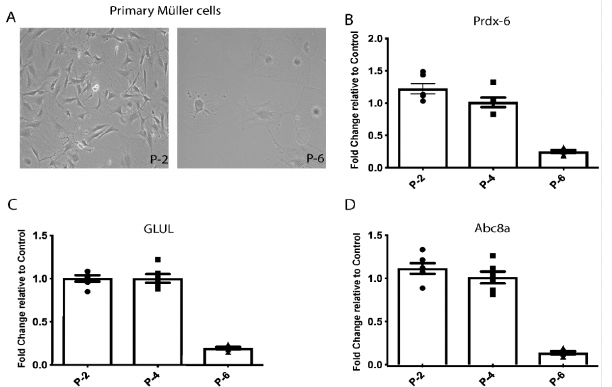
Figure 2. Primary Müller cells isolation from HspB4/ α A-crystallin knockout mice retain MGCs’ characteristics. Primary mouse MGCs retain an elongated morphology during the first few passages but become very flat by passage 6 ( A ). The isolated Müller cells show expression of specific markers such as peroxiredoxin-6 ( Prdx-6 ), glutamine synthetase ( GLUL ) and ATP-binding cassette 8a ( Abc8a ). Representative graphs of mRNA levels of ( B ) Prdx-6 , ( C ) GLUL , and ( D ) Abc8a in primary Müller cells at passage 2 (P-2), passage 4 (P-4), and passage 6 (P-6) are shown normalized to the actin-encoding gene Actb . The Müller-cell-specific markers are highly expressed until they dramatically decrease after passage